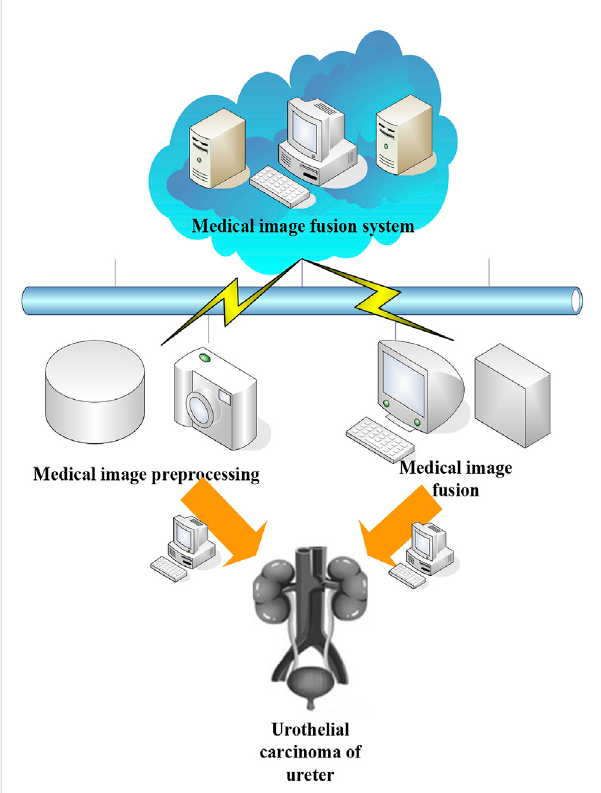
FIGURE 2 Application of medical image fusion in Urothelial Carcinoma of